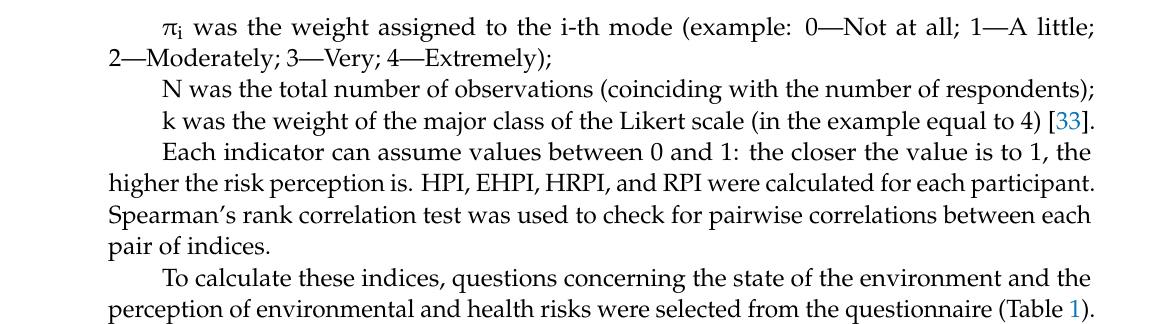
Table 1. Questions used to calculate the Hazard Perception Index, the Exposure Hazard Perception Index, the Health Risk Perception Index and the Risk Perception